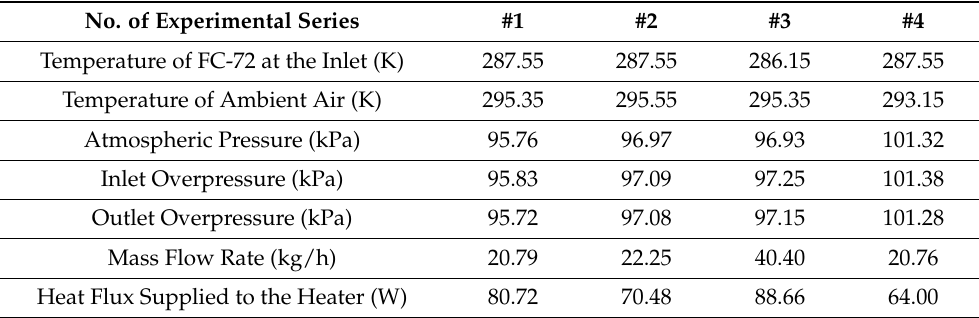
Table 1. The base characteristics of the selected experimental series.